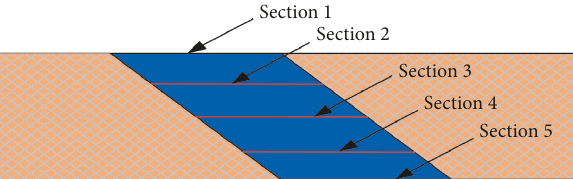
Figure 11: Measured sections of the cooling holes sample.